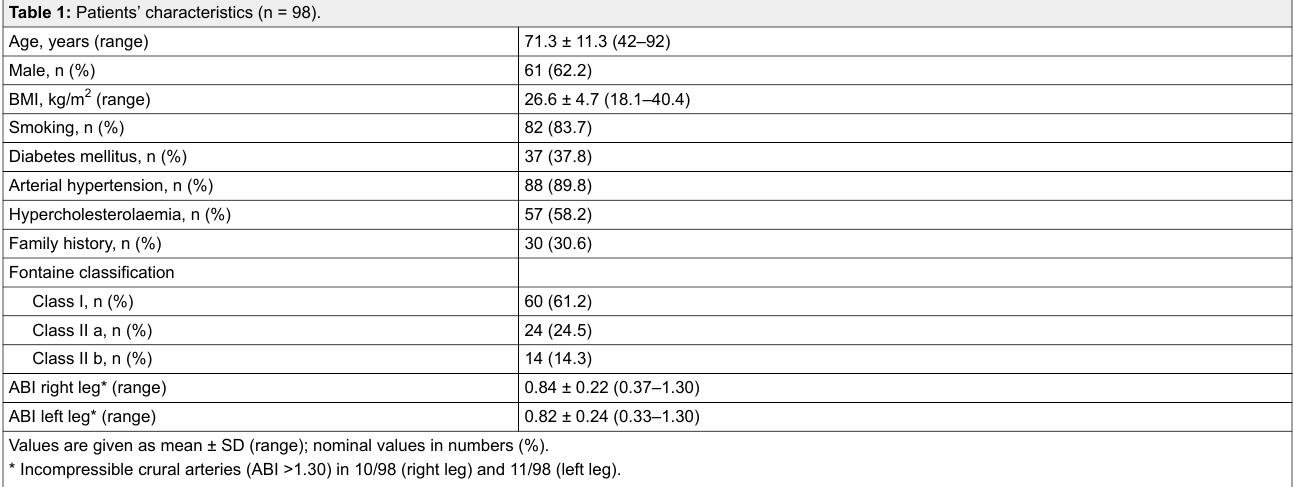
Table 1: Patients’ characteristics (n = 98).